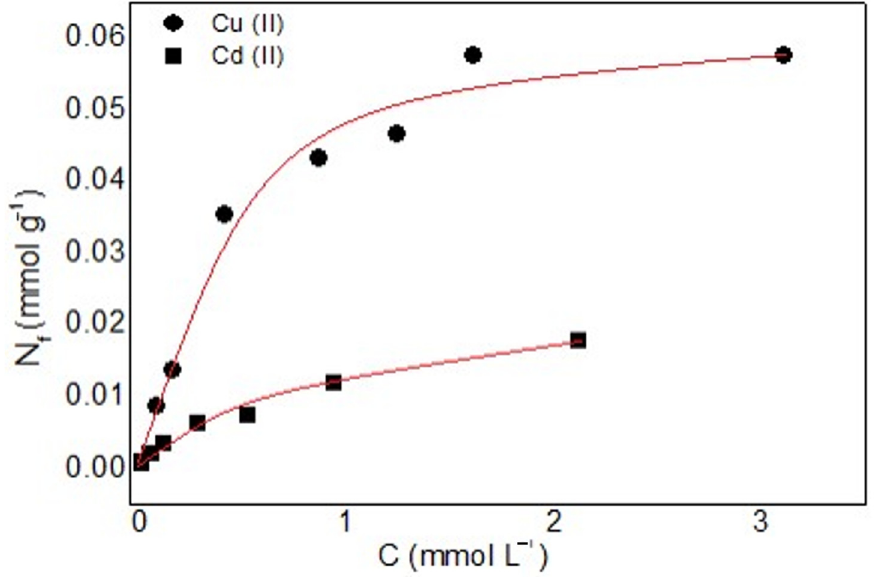
Figure 9. Isotherms for the adsorption of Cu(II) and Cd(II) in function of the metal concentration.